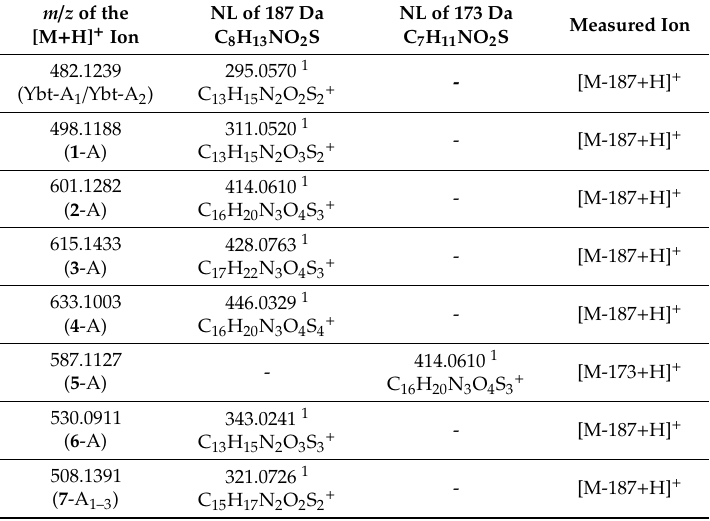
Table 4. m / z of the [M + H] + ions, the typical NLs, and the resulting main fragments of Ybt and its novel derivatives derived from LC-MS / HRMS data. The most intense ion, in this case the fragment resulting from the typical neutral loss, was used for the MS 3 experiments.